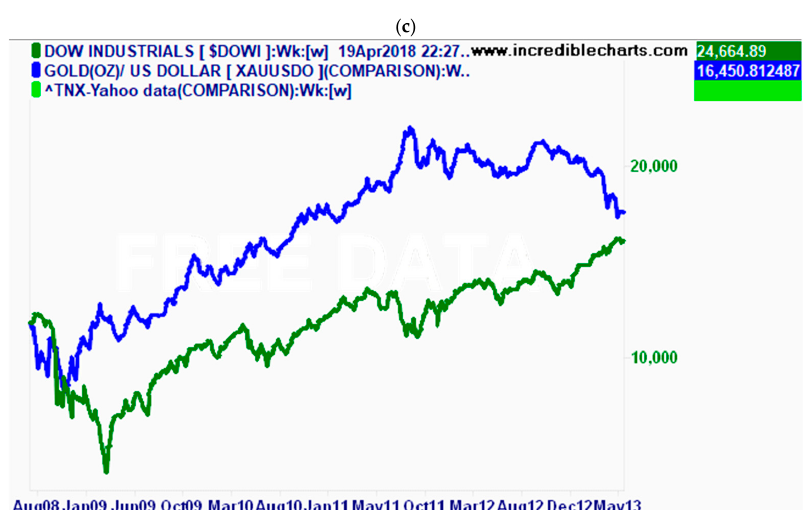
Figure 15. ( a – c ): Graphical comparison between titles evolution of different periods. Source: Authors’ processing is based on data available on Incredible Charts Pro.